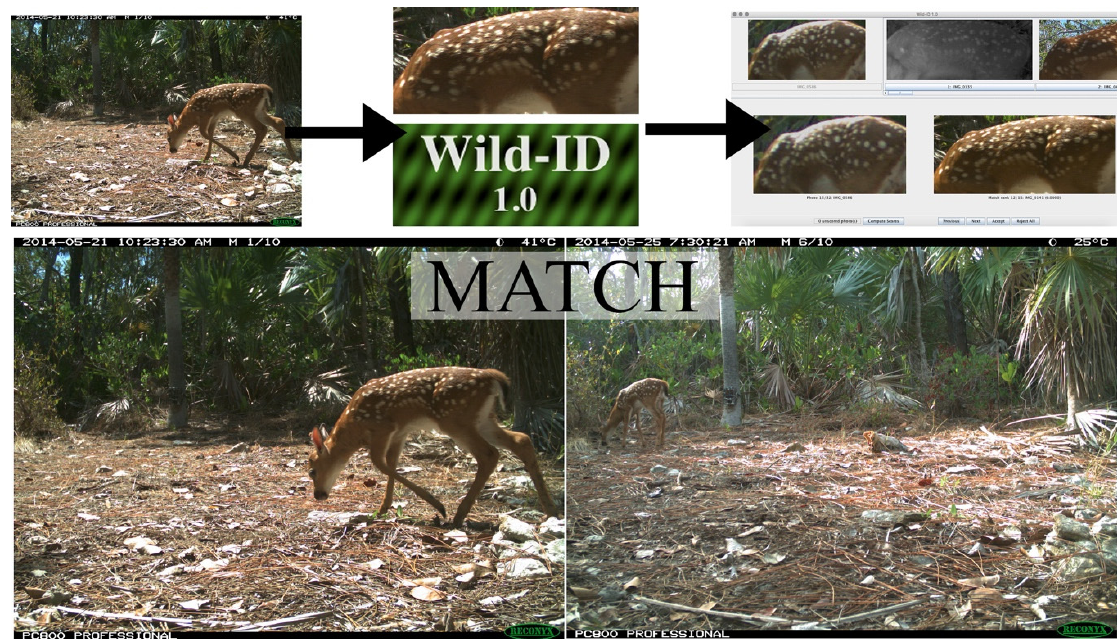
Figure 1. Workflow using Wild-ID to identify individual key deer ( Odocoileus virginianus clavium ) fawns from camera traps, 1 May–2 June 2014.